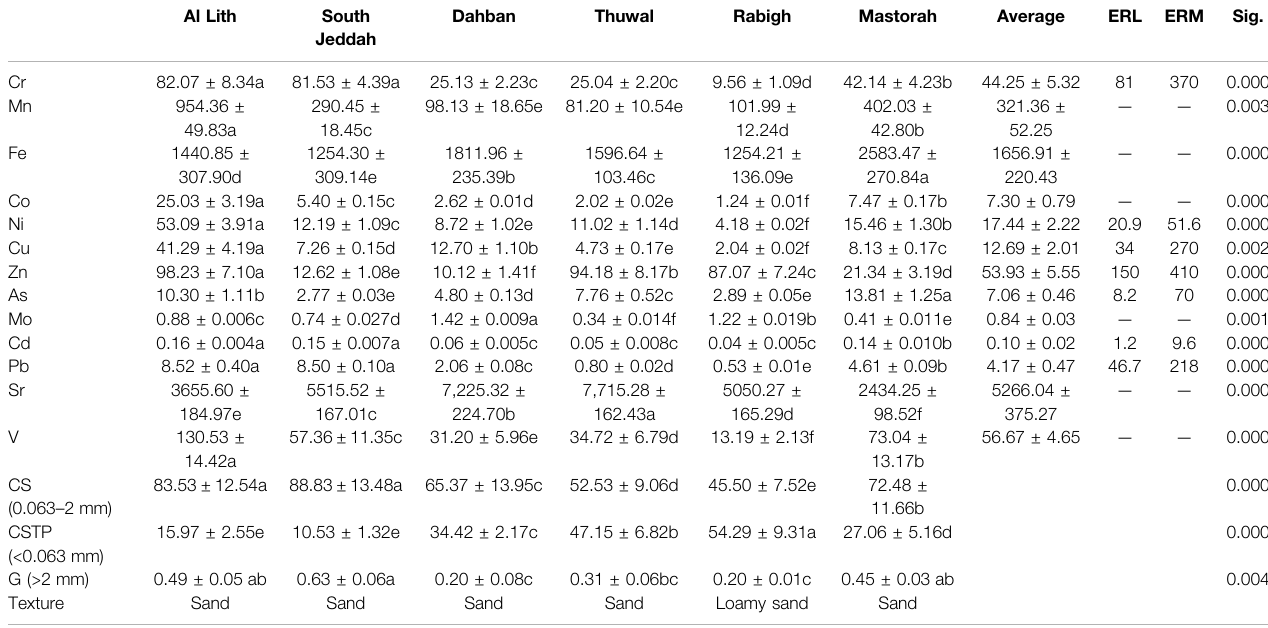
TABLE 1 | Heavy metal concentrations, sediment quality guidelines, and grain